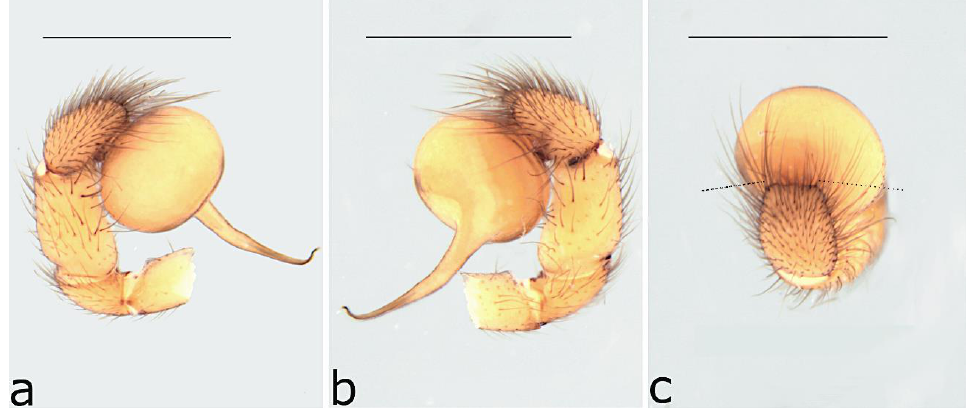
Figure 54. Ariadna simplex sp. nov. ♂ holotype (SAMA NN30482) from the Gammon Ranges (SA): ( a ) left pedipalp, prolateral view; ( b ) same, retrolateral view; ( c ) same, cymbium. Scale bar = 1 mm. Ariadna subplana sp.